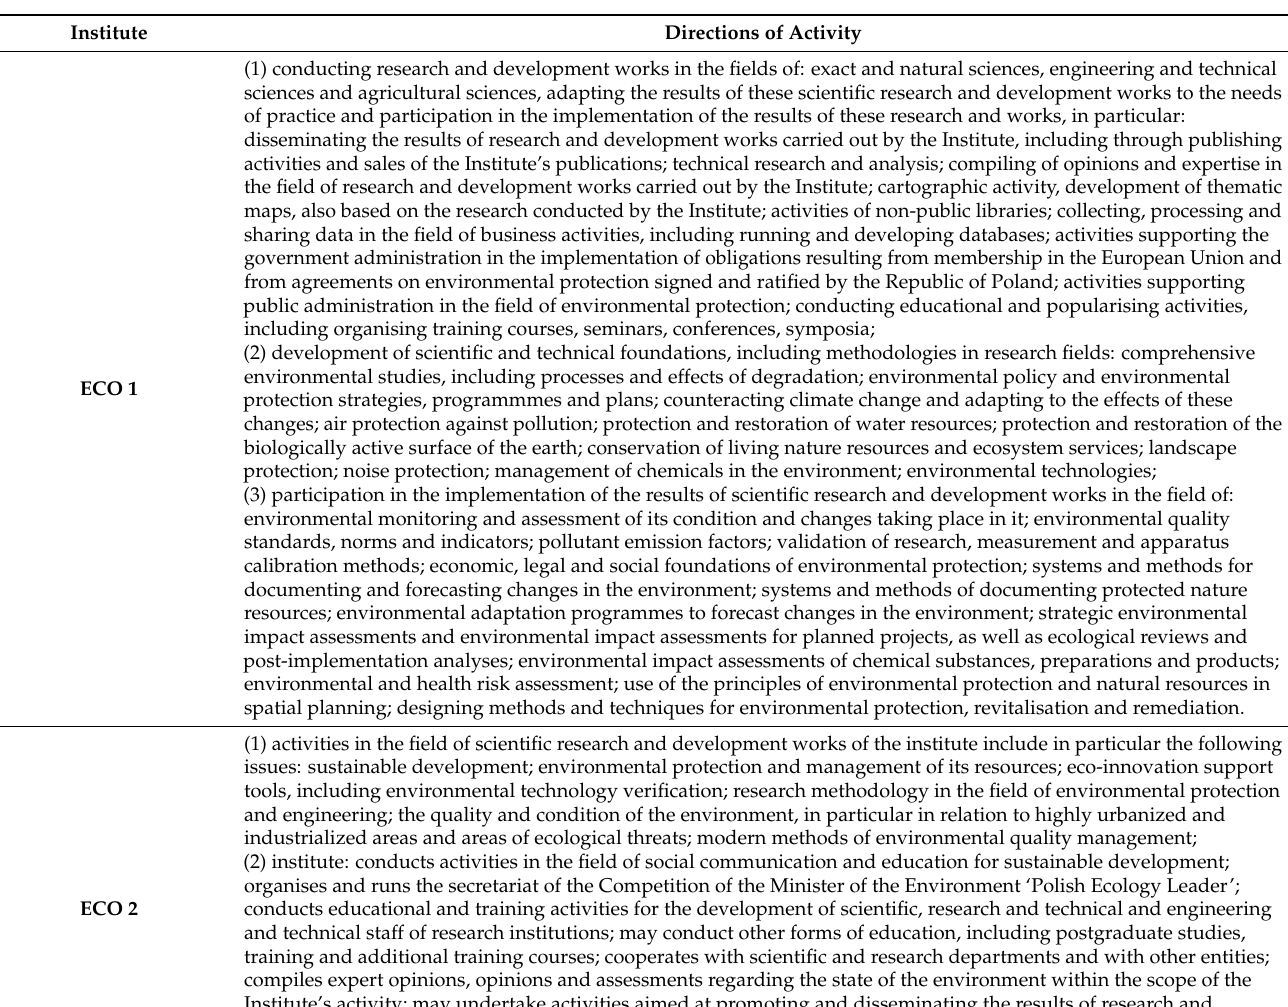
Table A1. A detailed description of the activities of the research institutes described in the